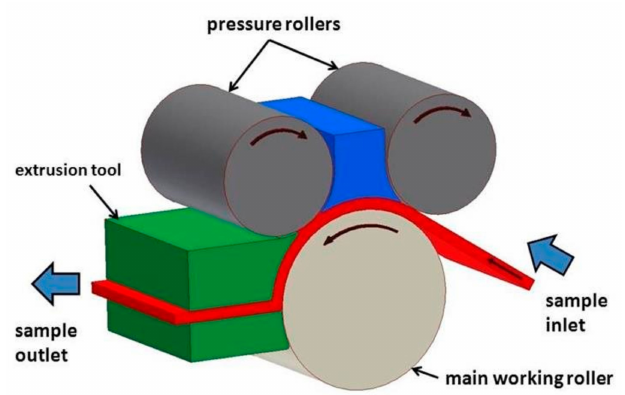
Figure 1. Principle of the dual rolls equal channel extrusion (DRECE)